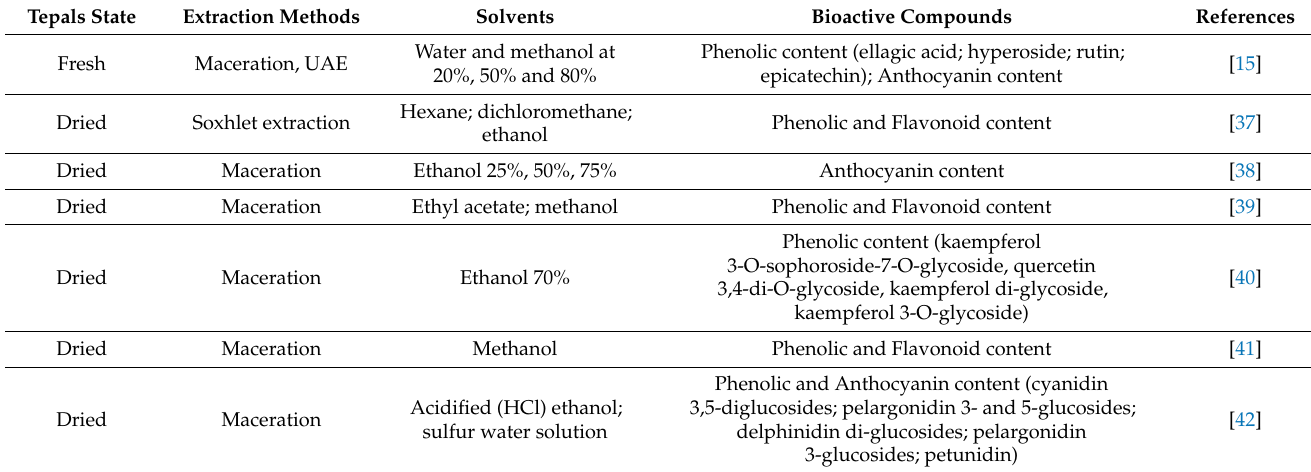
Table 4. Some representative studies of extraction methods and solvents to extract bioactive compounds from saffron tepals in different